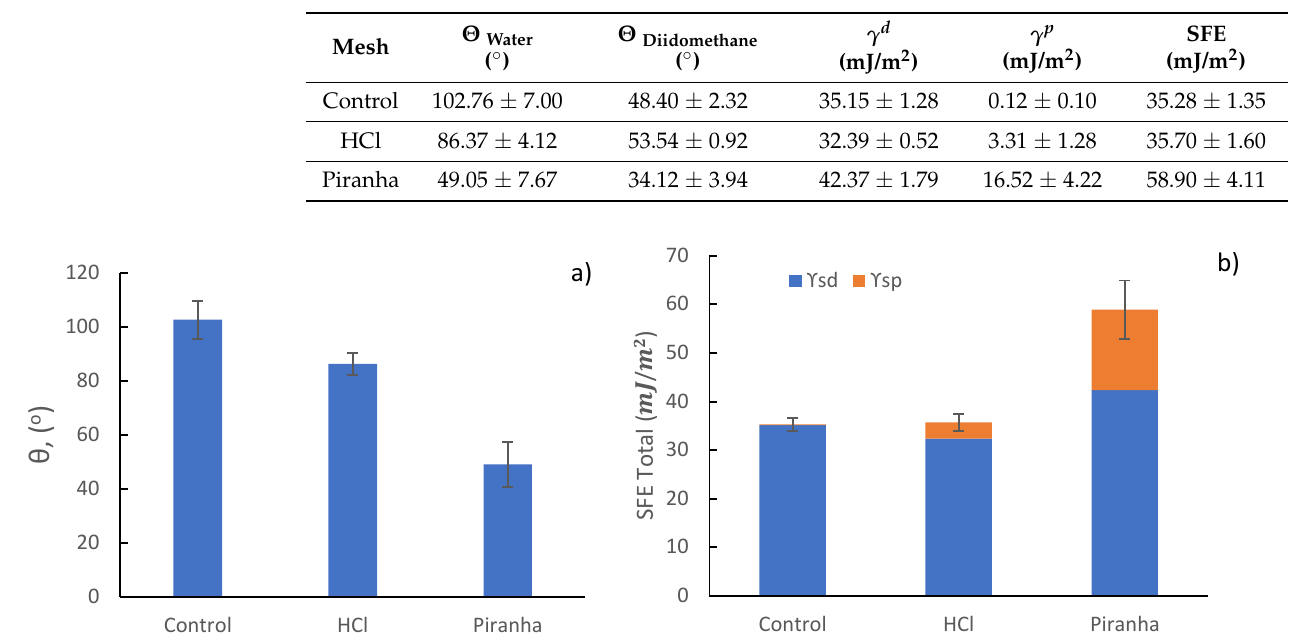
Table 4. Electrochemical and corrosion parameters assessed for Ti alloy meshes with different pas- sivation treatments.